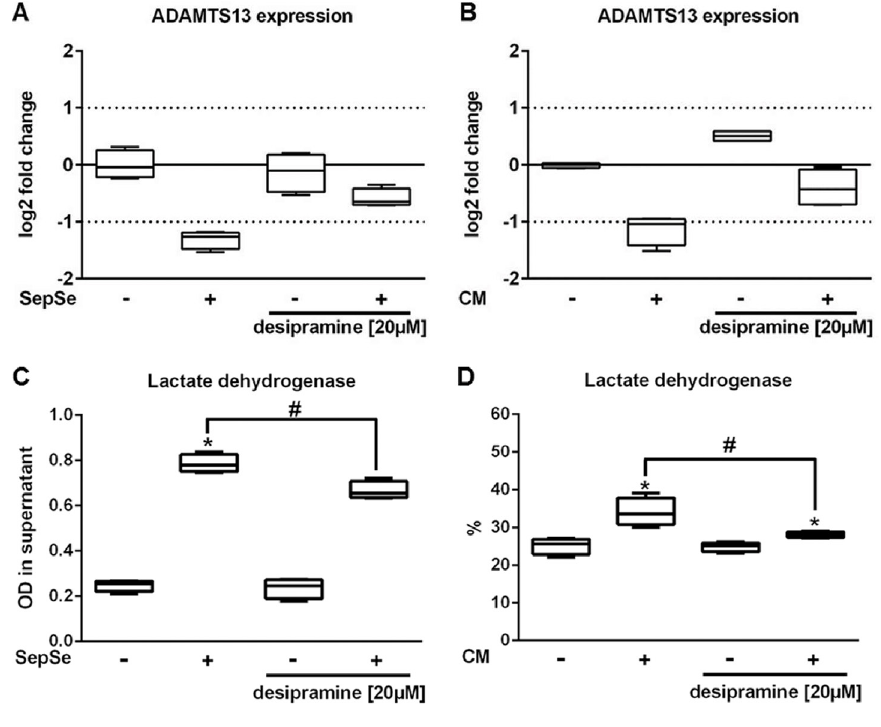
Figure 6. Desipramine improves endothelial stress response during sepsis. Semi-confluent HMECs (1 × 10 4 ) were incubated for 24 h with serum (5%) obtained from healthy individu- als, from patients with sepsis (n = 6) or proinflammatory cytokines (CM). (A, B) Co-incubation with desipramine (20 μmolL, preincubation for 24 h) abrogated ADAMTS13 expression as normalized to reference transcript GAPDH . Desipramine treatment of HMECs diminished LDH release into the supernatant following the stimulation with serum obtained from sepsis patients (C) or proinflammatory cytokines (D). The boxes indicate the interquartile range, divided by the median (central horizontal line) as analyzed in at least four independent experiments. OD optical